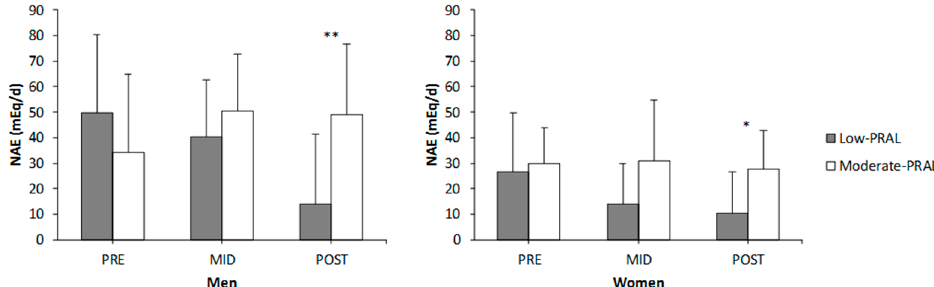
Figure 1. Net acid excretion (NAE) in the low-PRAL and the moderate-PRAL diet groups before (PRE), in the middle (MID) and after (POST) the 12-week diet period. * p < 0.05, ** p < 0.01 statistically significant difference between the diet groups at POST (two-way repeated measures ANOVA, an independent t -test).